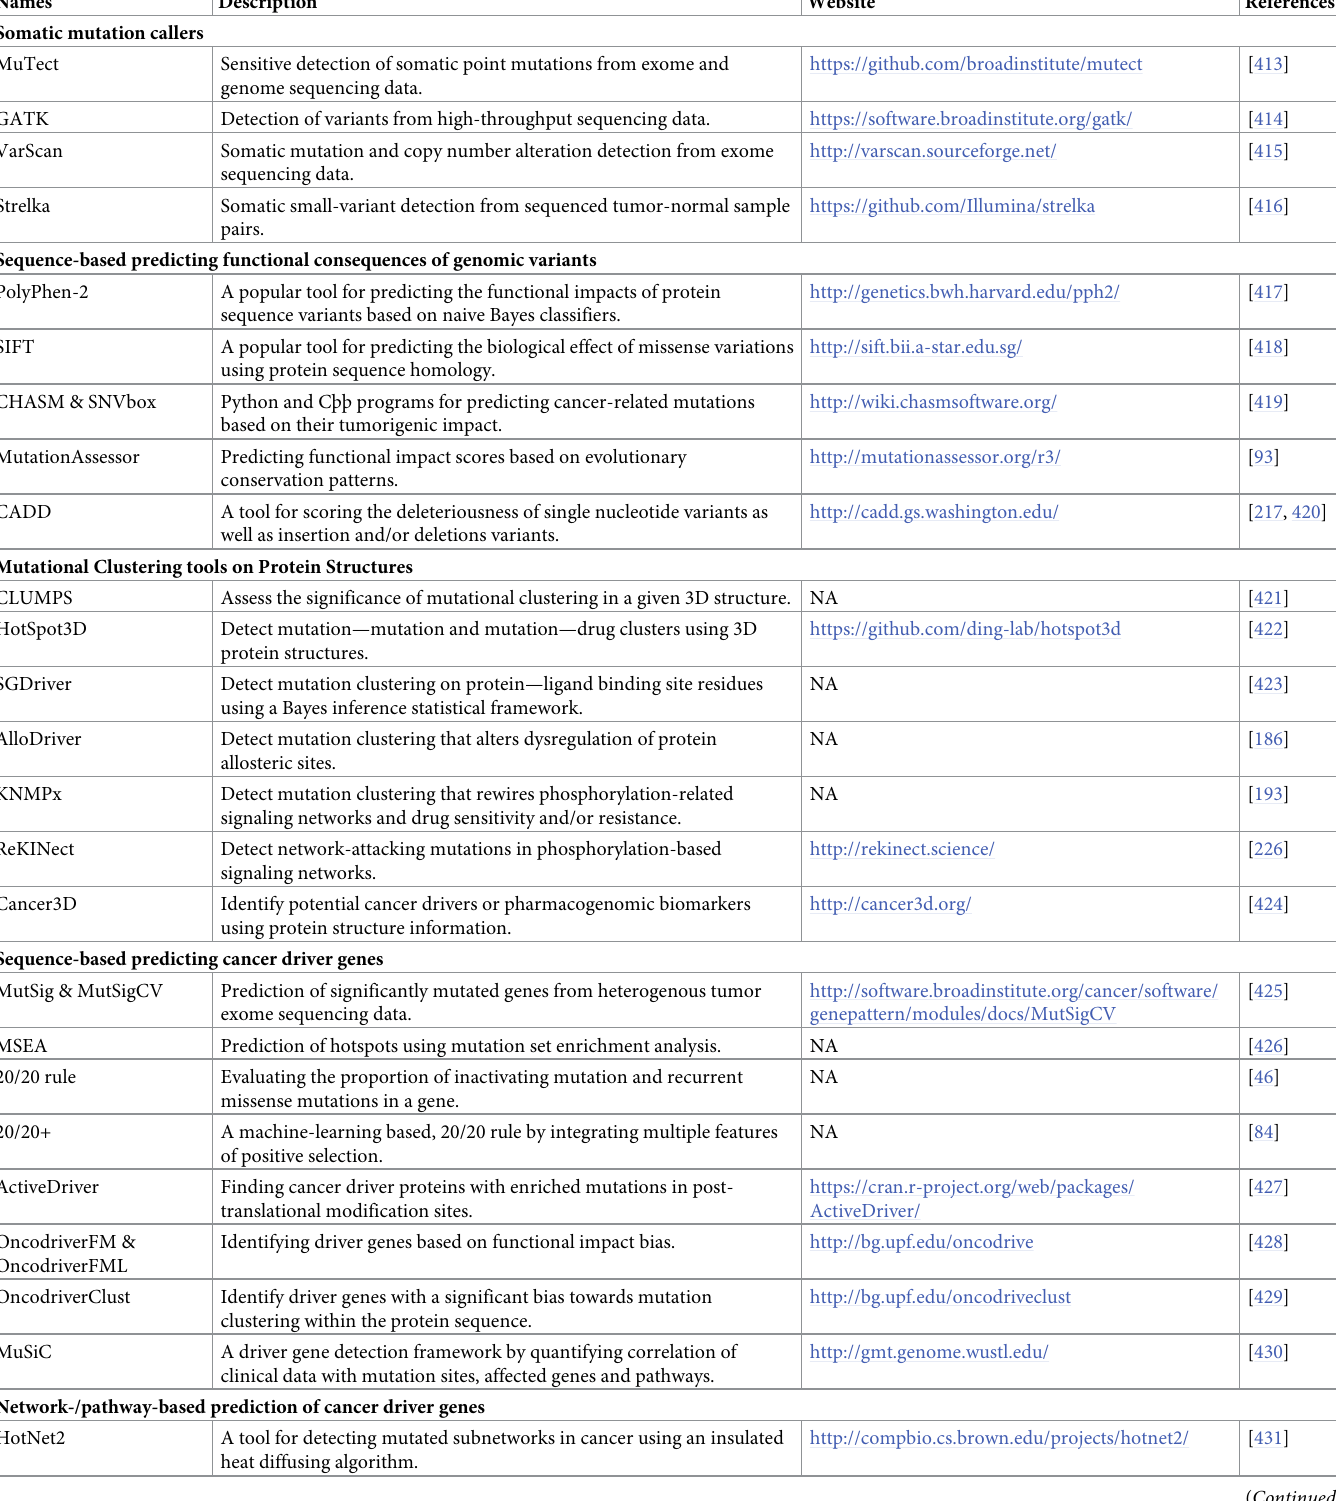
Table 1. Computational and bioinformatics tools for personalized cancer